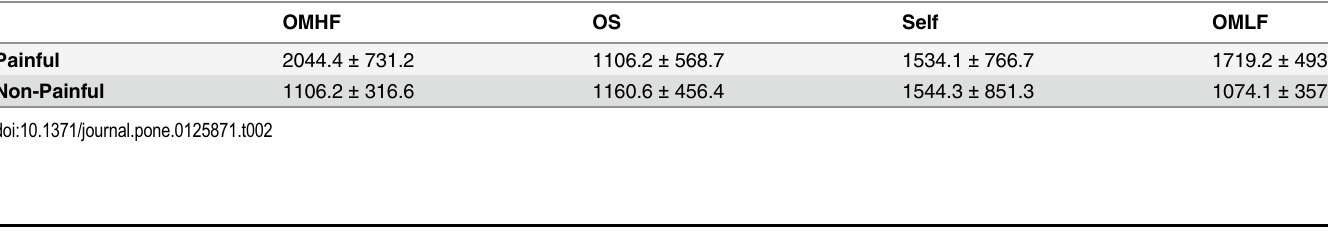
Table 2. Response time (Means values ± SD) as a function of stimuli and perspective.